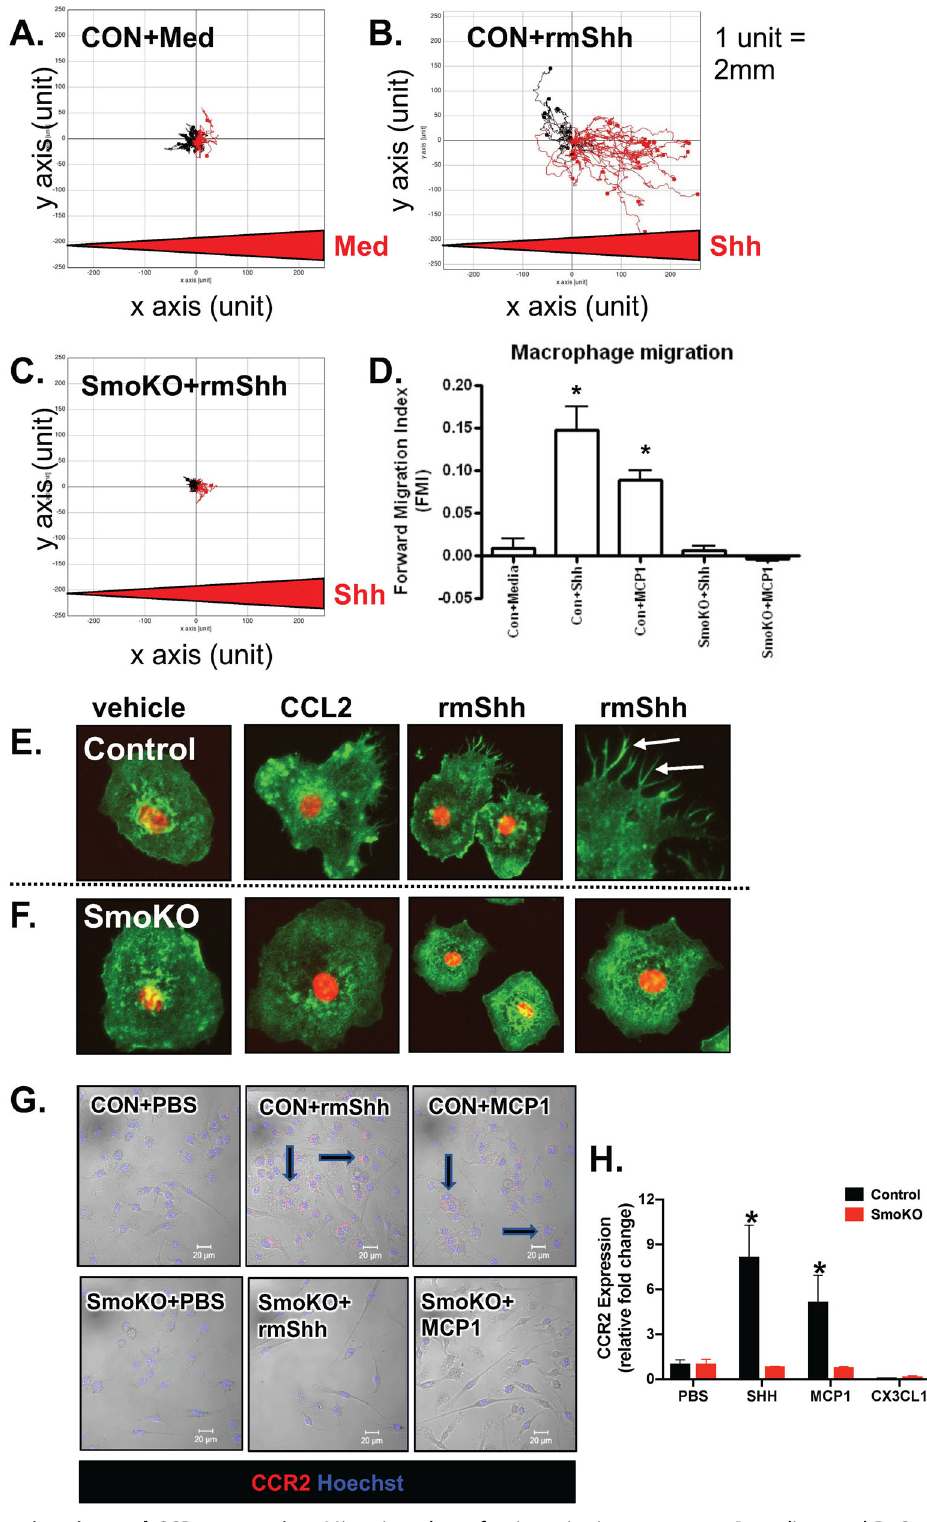
Fig. 4 Macrophage migration and CCR2 expression. Migration plots of trajectories in response to A medium and B , C rmShh gradient using macrophages cultured from the bone marrow of control and SmoKO mice. D Macrophage migration is represented as forward migration index (FMI). Representative immuno fl uorescence stains of actin (green) and nuclei (red) of bone marrow-derived macrophages cultured from E control and F SmoKO mice treated with vehicle, CCL2, or rmShh. Arrows indicate fi lopodia. G Representative immuno fl uorescence stain of CCR2 (red) and nuclei (Hoechst, blue) of bone marrow-derived macrophages cultured from control or SmoKO mice and treated with PBS, rmShh, or MCP. H Quantitative RT-PCR of CCR2 expression using RNA collected from control or SmoKO bone marrow-derived mouse macrophages and treated with PBS, Shh, MCP1, or CXC3L1. * P < 0.05 compared to PBS vehicle control, n = 6 individual cultures. Data are shown as the mean ±